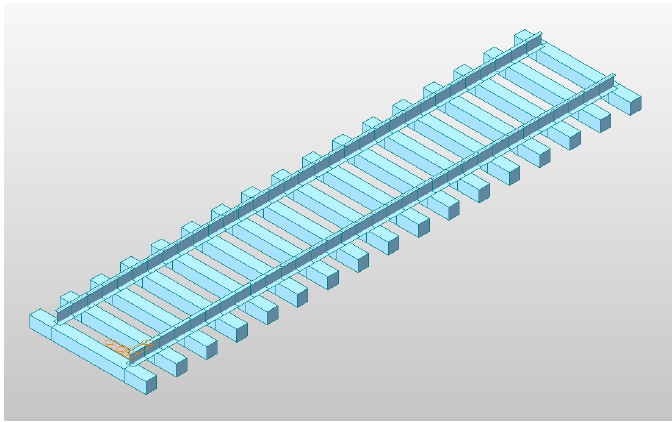
Figure 8. Dimensional analytical model. Table 7. Track properties for finite element analysis.